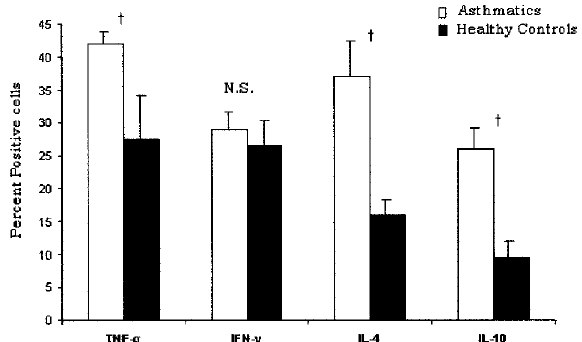
FIG. 2. Expression of TNF- a , IFN- g , IL-4 and IL-10, on induced sputum gd T cells in asthmatic patients and in healthy controls analysed by double immunofluorescent staining and flow cytometry.† Significantly different between asth- matic patients and healthy controls ( p < 0.001); N.S., not significantly different.